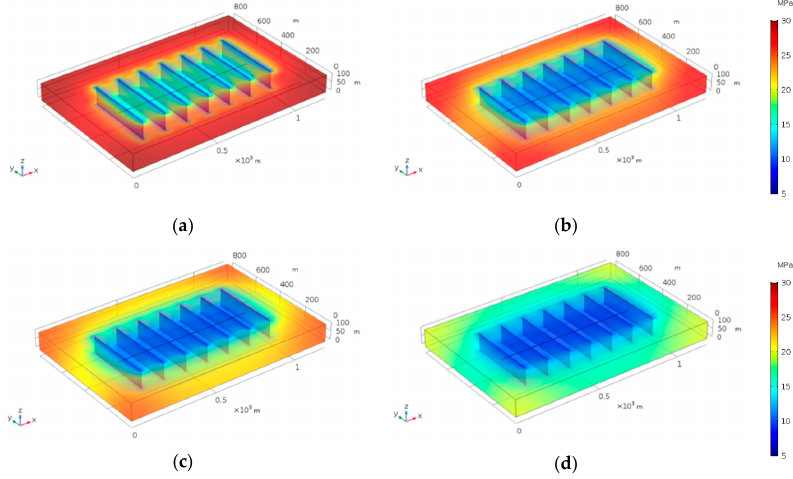
Figure 8. Reservoir pressure distribution at different production times. ( a ) T = 1a; ( b ) T = 3a; ( c ) T = 5a; ( d ) T = 10a.